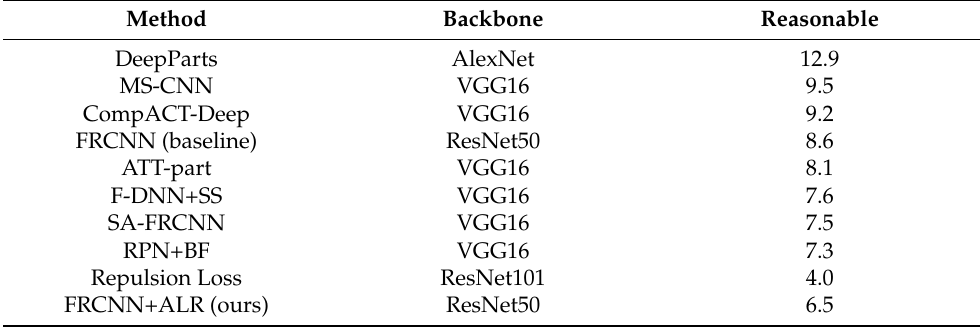
Table 6. Comparisons of the proposed FRCNN+ALR framework with other methods on the standard test set of the Caltech-USA dataset using new annotations (MR − 2 /%).